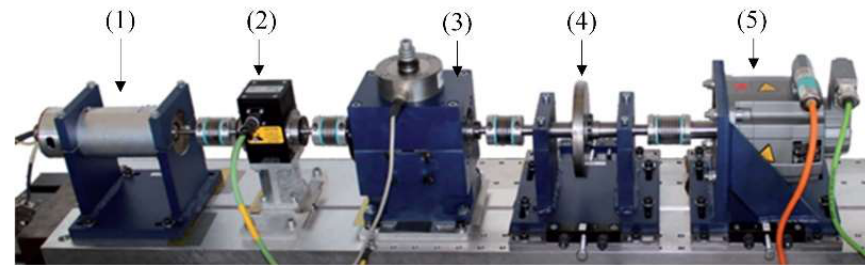
Figure 13. Test rig of Paderborn bearing dataset.